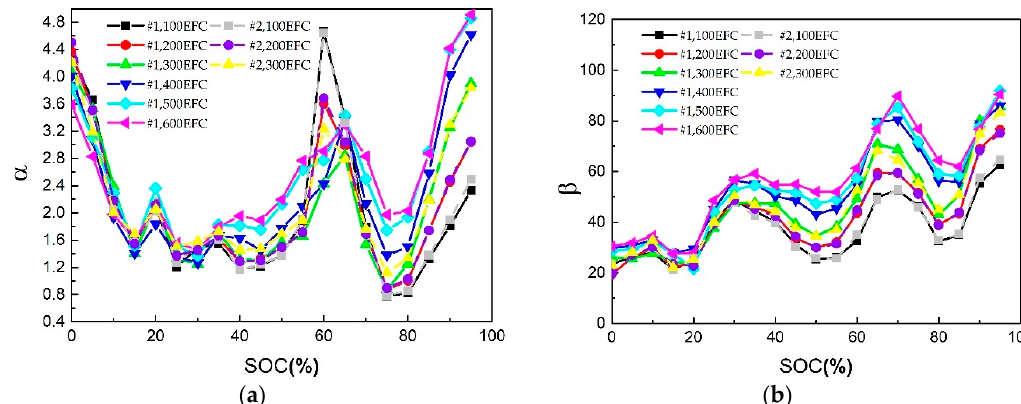
Figure 8. Relationships between relaxation model parameters and SOC under different aging states after discharging condition. ( a ) results of α ; ( b ) results of β .